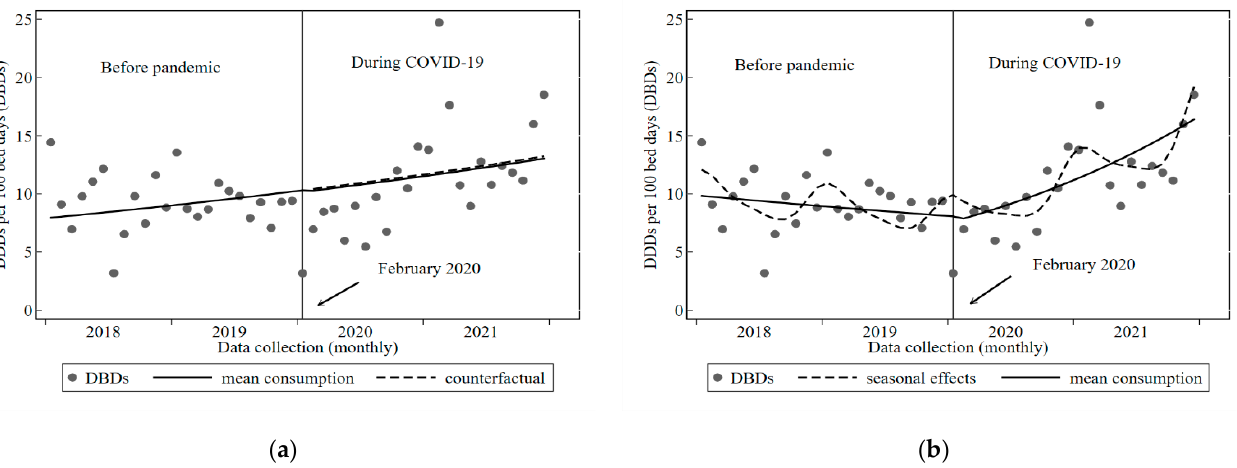
Figure 1. Inpatient antibiotic consumption at Vila Central Hospital, Vanuatu before and during COVID-19, 2018 to 2021: ( a ) Unadjusted model showing counterfactual; ( b ) Final model showing seasonal effects.